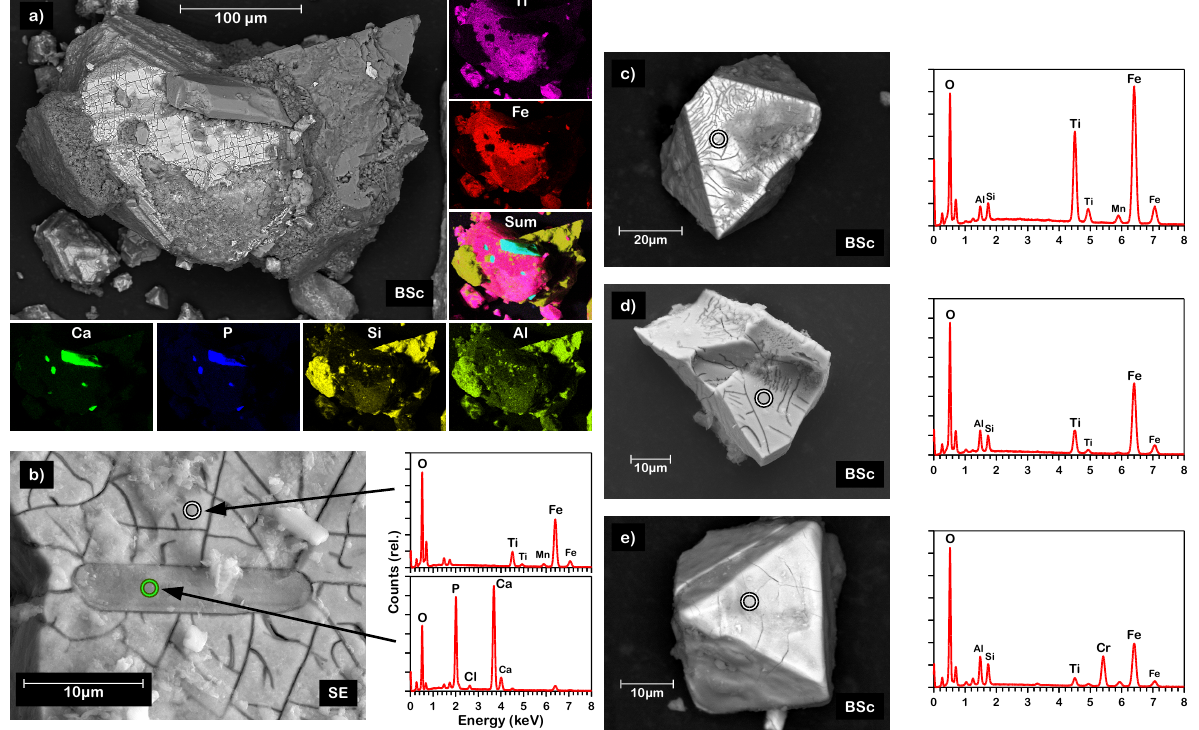
Fig. 9. Scanning electron microscope (SEM) analyses of magnetic extracts from creek sediments from the northwestern shore of El’gygytgyn: (a) SEM image and elemental mapping of a large ( ∼ 400mum) titanomagnetite grain, Fe 3-x Ti x O 4 (0 ≤ x ≤ 1), represented by the Fe and Ti mappings. The titanomagnetite is still encrusted by minerals of the host rock, where bright patches in the P and Ca mapping indicate the presence of apatite, Ca 5 (PO 4 ) 3 (Cl, F, OH), whereas mappings of Al and Si reflect the distributions of silicates. (b) A close-up of an- other titanomagnetite with apatite inclusion, together with associated EDS analyses. (c) Idiomorphic and (d) irregular titanomagnetite grain. (e) Idiomorphic Cr-bearing magnetite, FeFe (2-x) Cr x O 4 (0 ≤ x ≤ 2). More or less distinctively visible shrinkage cracks in all grains indicate low-temperature oxidation (maghemitization). The circles from (b) to (e) mark the locations of EDS analyses. EDS – energy dispersive X-ray spectroscopy, BSc – back scatter electrons, SE – secondary electrons.